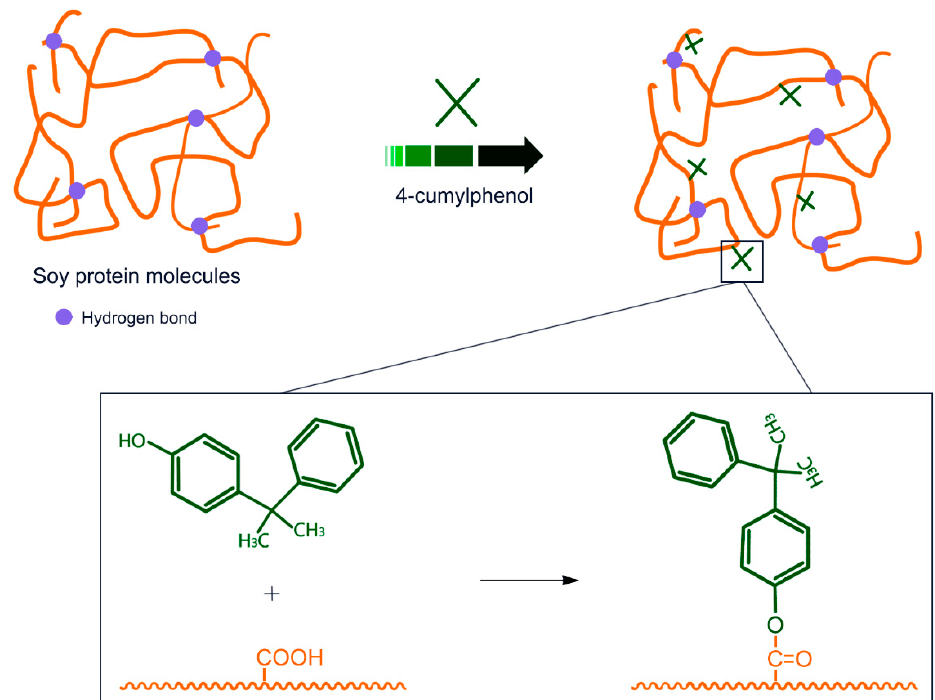
Figure 4. Interactions between soy protein and 4-cumylphenol.